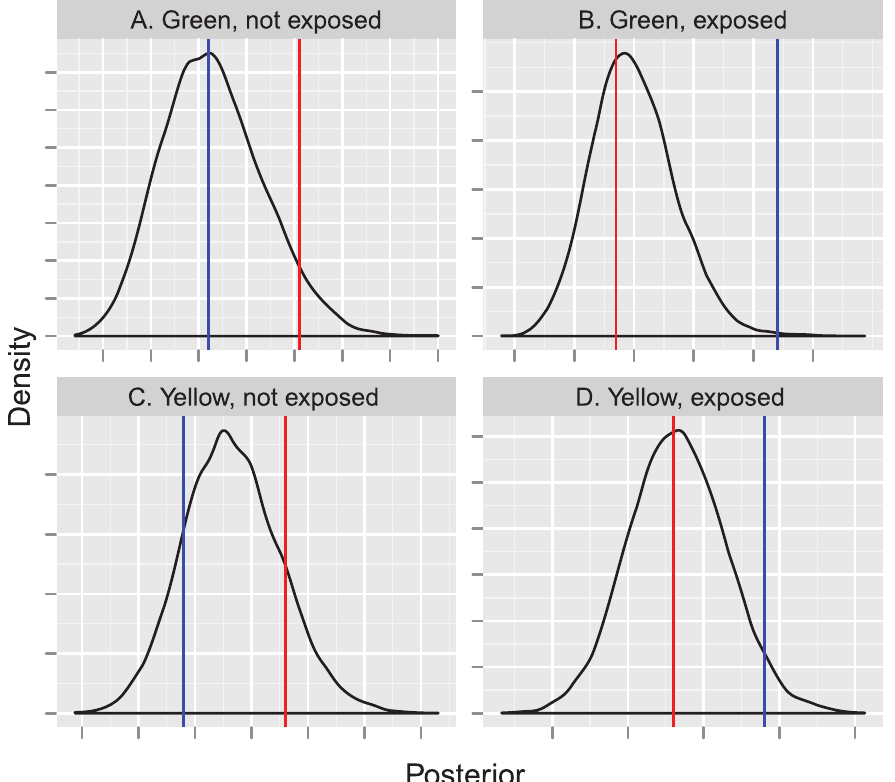
Figure 7. Posterior distributions for the abundance (number of groups) of golf tees of different types. Kernel density estimates of posterior distributions are in black, while true values are represented by red vertical lines, and estimates from a conventional mark-recapture distance sampling analysis (see Laake and Borchers [7]) are presented in blue.